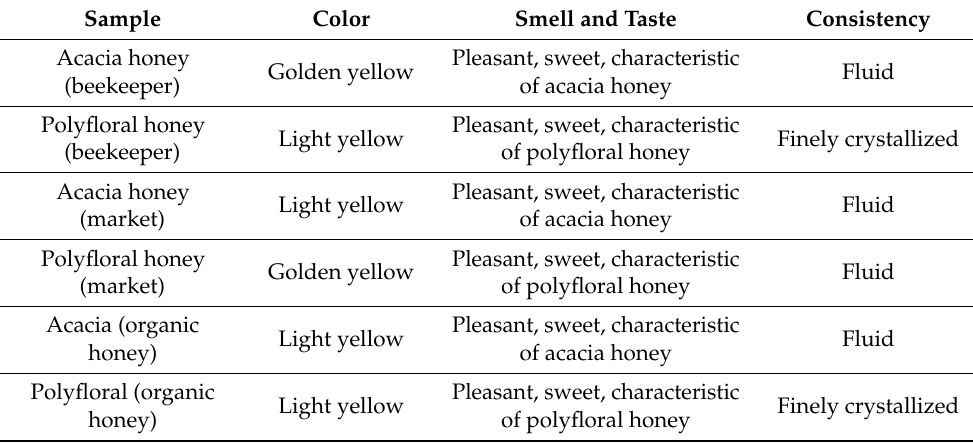
Table 2. Organoleptic parameters of the analyzed honey samples.